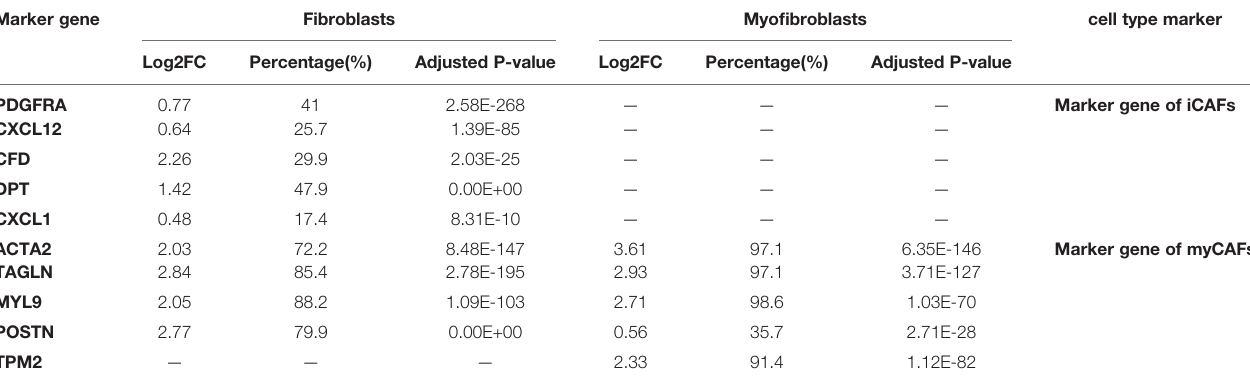
Theannotated ‘ Fibroblasts ’ expressedhighlevelsofmarkergenesofin fl ammatoryCAFs,andthe ‘ myo fi broblasts ’ expressedgenesthatindeedexpressedbymyo fi